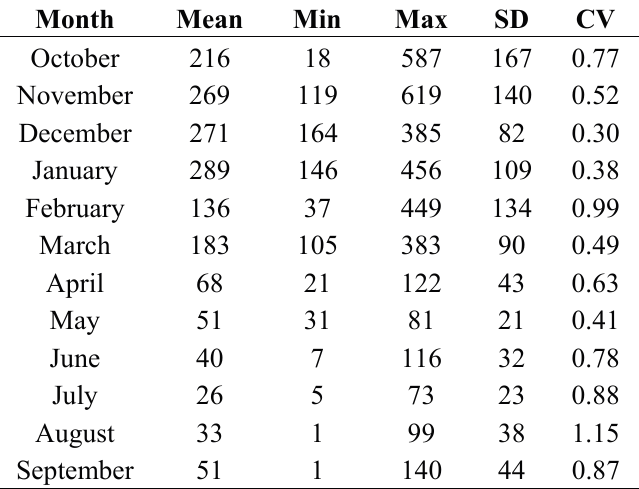
Table 3. Monthly mean, minimum, and maximum precipitation values, along with standard deviations and coefficients of variation for each month in mm from 1996 to 2005.